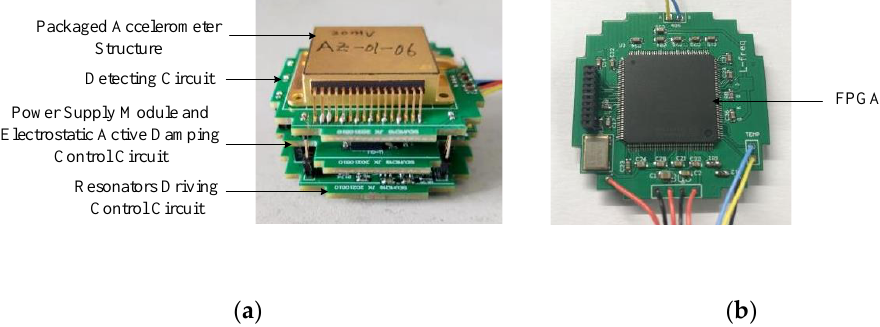
Figure 12. Photographs of the micromachined silicon resonant accelerometer: ( a ) packaged accel- erometer structure and peripheral circuitry and ( b ) frequency measurement module.